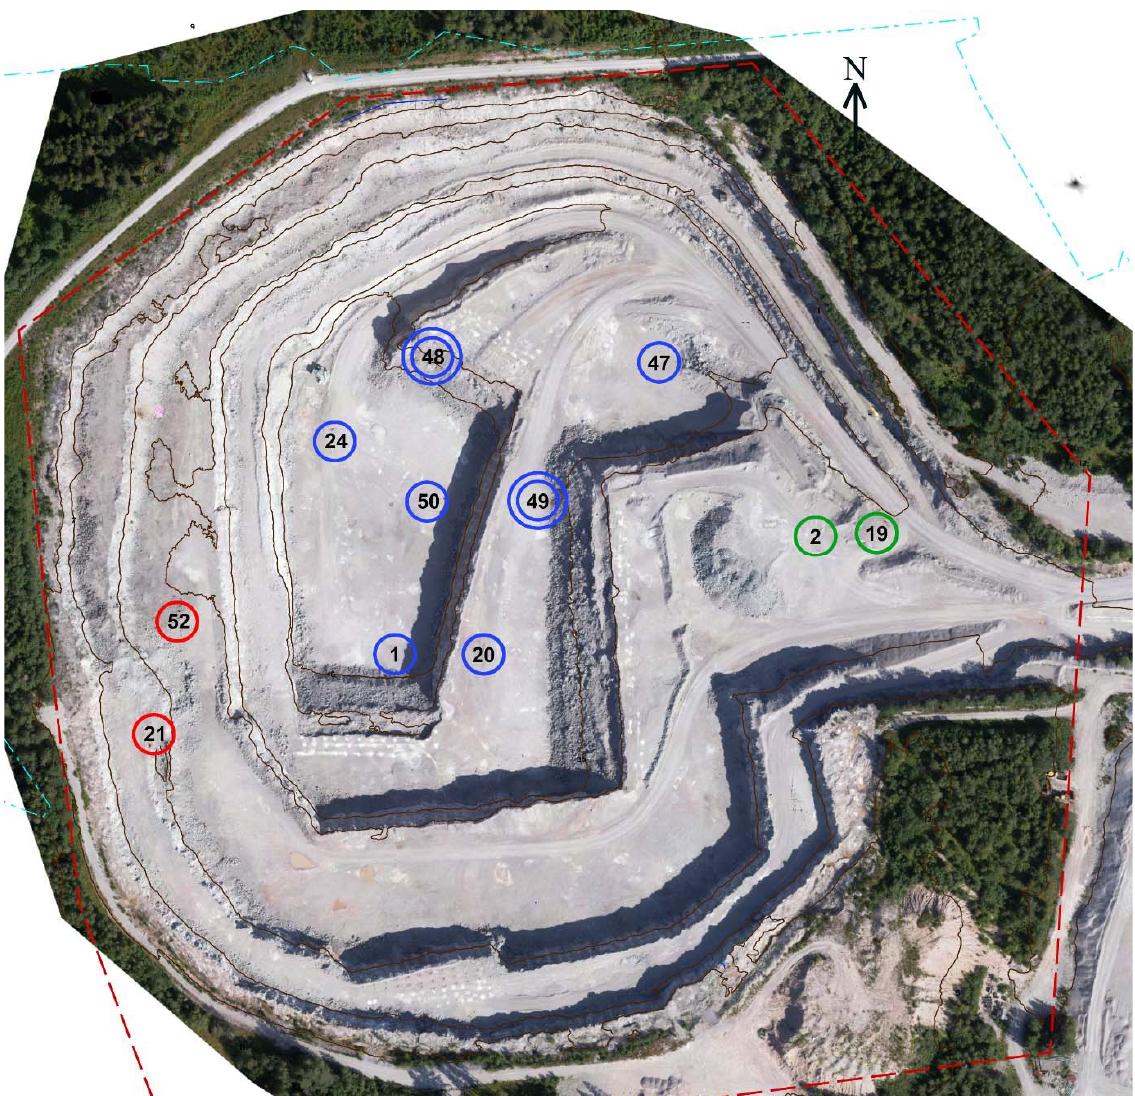
Figure 1. Aerial photograph of Jutjärn quarry. The boreholes are numbered, and the sampled boreholes are marked with a red, blue, or green circle. Two samples were taken from the double ‐ blue ‐ marked boreholes for further investigation of crack formation. For a more detailed regional geological map, visit: https://apps.sgu.se/kartvisare/kartvisare ‐ berg ‐ 50 ‐ 250 ‐ tusen.html?zoom= ‐ 1202129.5840071687,6016943.2639965275,2381877.5840071687,7752946.7360034725 (accessed on: 10/08/22).